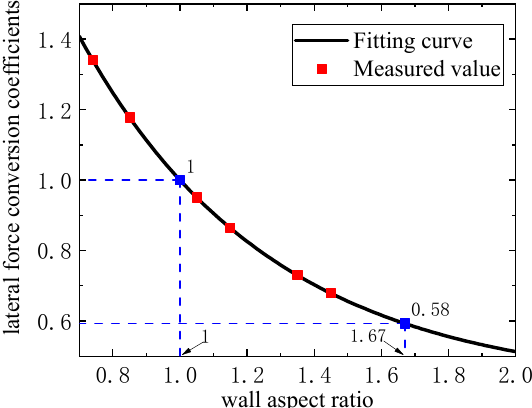
Figure 16. Corresponding relationship of different wall aspect ratios and their lateral force conversion coefficients.